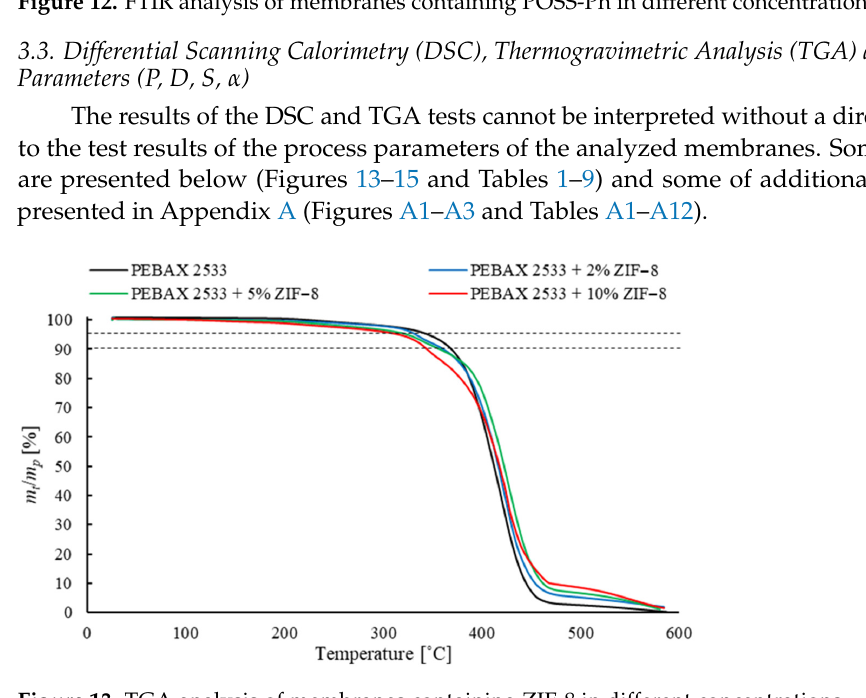
Figure 12. FTIR analysis of membranes containing POSS-Ph in different concentrations.